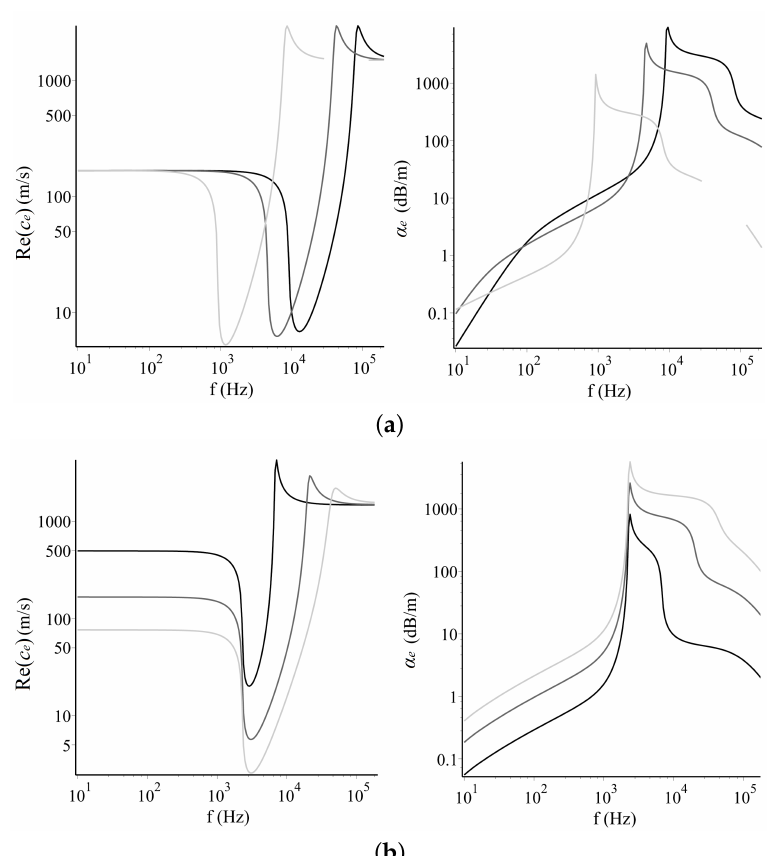
Figure 13. ( a ) Influence of bubble size on the wave speed (left) and attenuation (right) in an air-water mixture with constant air–volume fraction V a = 0.01. From black to light grey the radius of the bubbles in the mixture increases gradually, i.e., 0.5 mm, 1 mm and 5 mm. ( b ) Influence of the air–volume fraction in the wave speed (left) and attenuation (right) of a bubbly medium consisting of bubbles with a radius of α = 2 mm. From black to light grey the air–volume fraction increases, i.e., 0.1%, 1% and 5%. Reprinted from Tsouvalas, A.; Metrikine, A. Noise reduction by the application of an air bubble curtain in offshore pile driving. Journal of Sound and Vibration 2016, 371, 150–170. Copyright 2016, with permission from